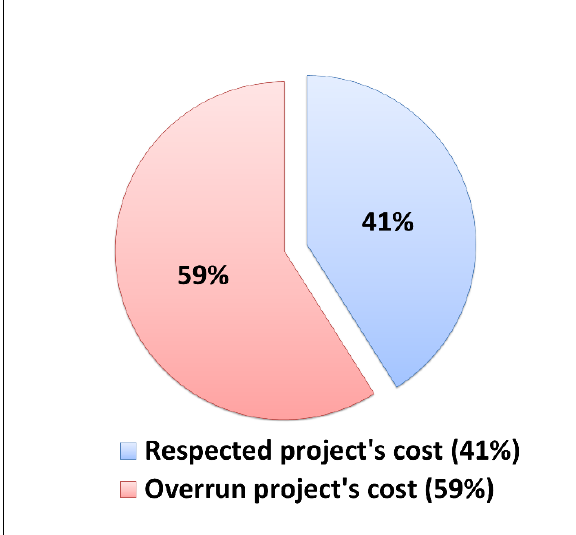
Figure 1 : Compliance with the budget for 190 public building projects in Czechia (Source: author) Of the total sample of 190 projects (implemented in the period 2008 to 2018), in 59% of them a misconduct was found, which led to project cost overrun, as summarized in Figure 2. The main reasons for budget overrun were: changes and errors in design documents (32%), inadequate geological research (14%), complications or changes in building technology (12%), climate changes (9%), errors in project budget (6%), failure to meet the deadline by subcontractors, archeological research (4%), unprofessional project management (4%).